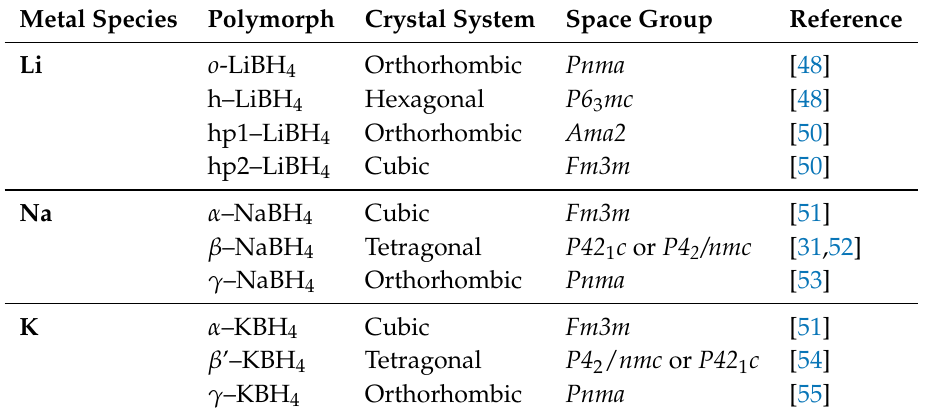
Table 2. Known experimental structures of the common alkali borohydrides MBH 4 (M = Li, Na, K) [32]. Metal